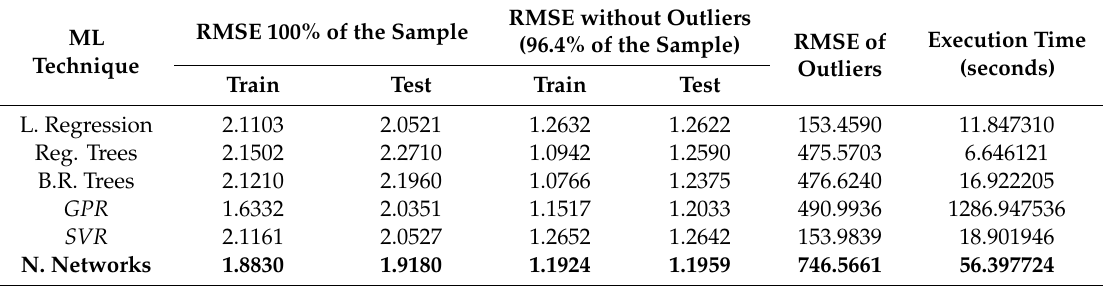
Table 15. SSDE-CTDI VOL results for Thorax, Abdomen, & Pelvis